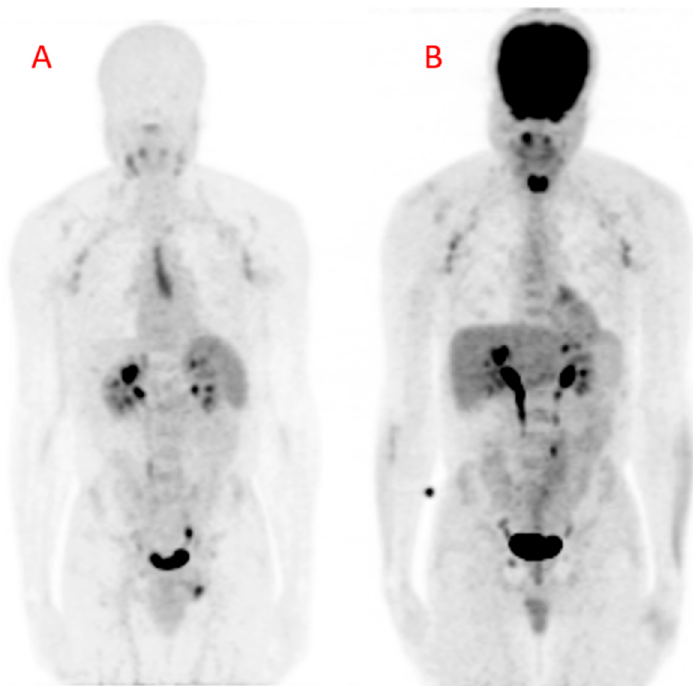
Figure 4. Maximum intensity projection (MIP) images obtained from ( A ) Gallium-68 pentixafor positron emission tomography ([ 68 Ga]Ga-pentixafor PET) and ( B ) fluorine-18 fluorodeoxyglucose positron emission tomography ( 18 [F]FDG PET) in a 42-year-old HIV-infected male. There are